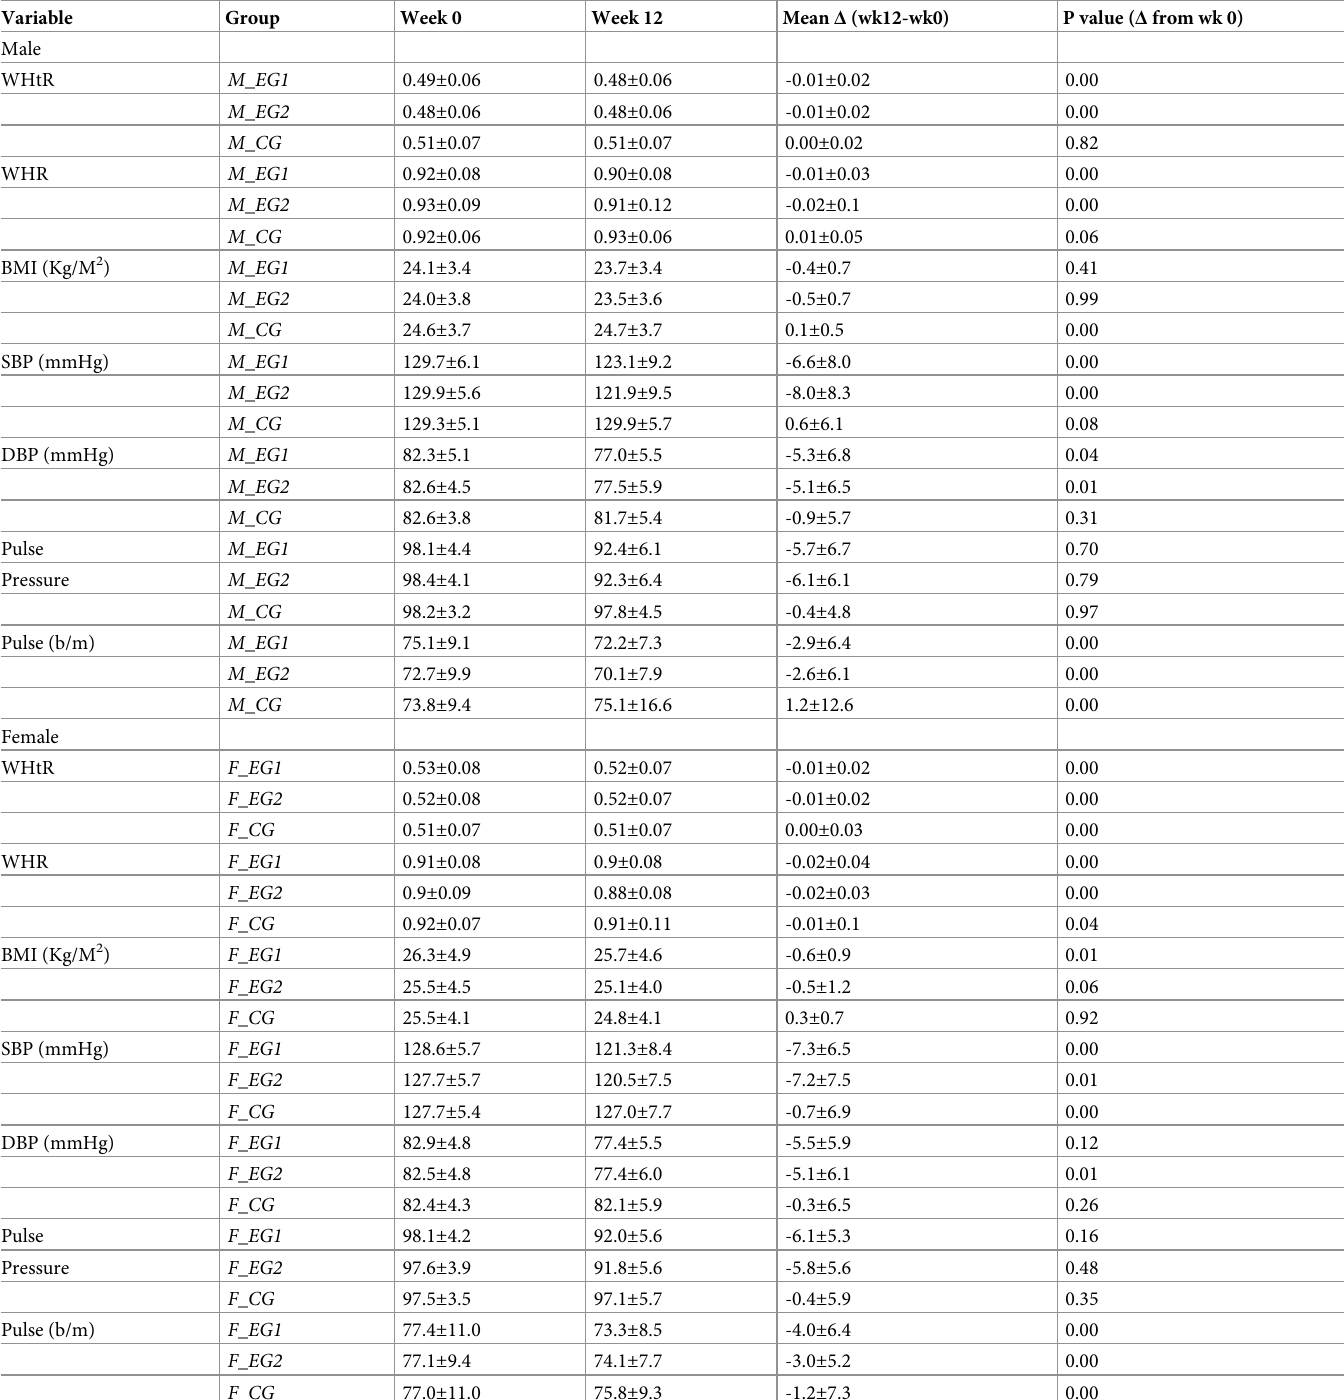
Table 2. Cardiovascular and body composition measurements between weeks 0 and 12.